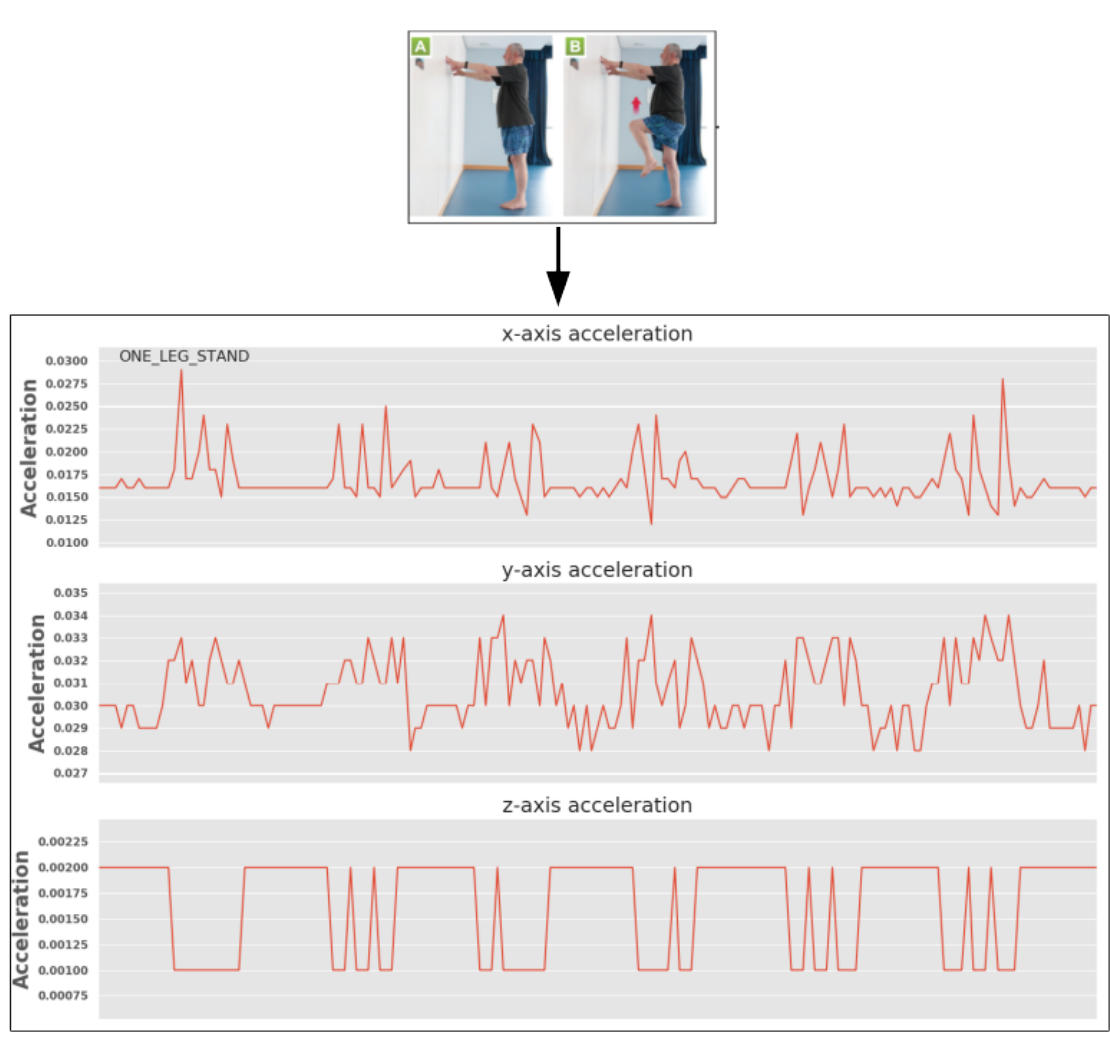
Figure 11. One leg